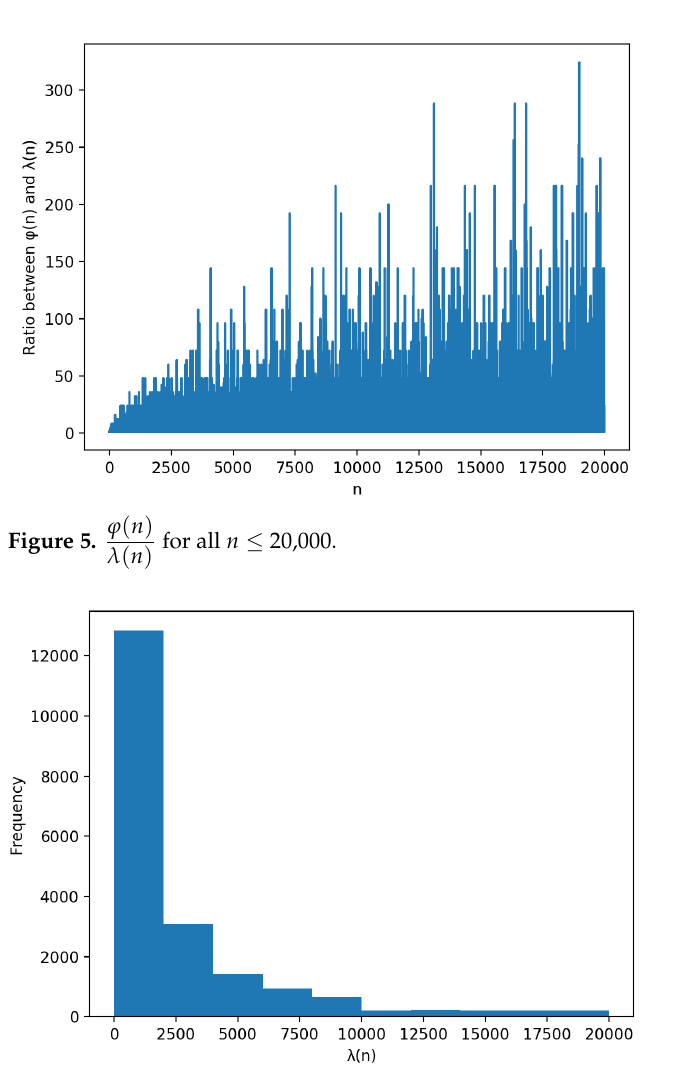
Figure 6. The Cardinal of the Inverse of Carmichael function.